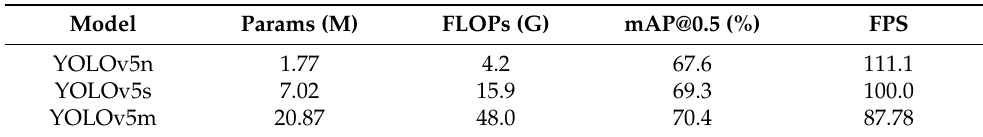
Table 1. Performance comparison of different YOLOv5models.